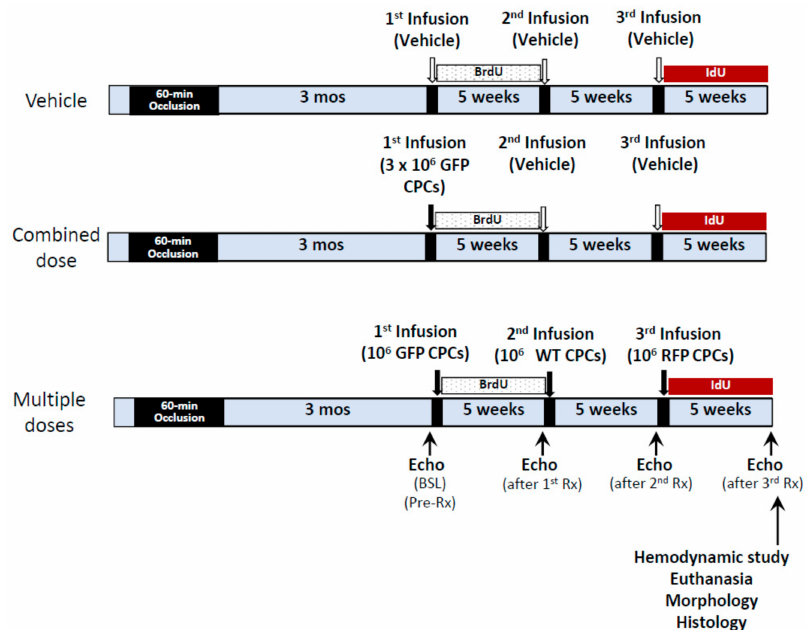
Figure 8. Experimental protocol. The model of chronic ischemic cardiomyopathy was created by producing an MI with a 60-min coronary artery occlusion followed a 90 days of reperfusion. Three months after MI, mice received the 1st treatment (vehicle or CPCs either 1 × 10 6 or 3 × 10 6 ) via echo-guided intraventricular injection, followed by 2nd and 3rd injections (vehicle or CPCs 1 × 10 6 ) at 5-week intervals. Serial echocardiographic studies were performed before and 5 weeks after each injection. BrdU was given via mini-osmotic pumps for 5 weeks starting right after the 1st injection (until the 2nd injection). IdU was started right after the 3rd injection and continued for 5 weeks until euthanasia. Mice then underwent hemodynamic studies and the hearts were fixed for histological